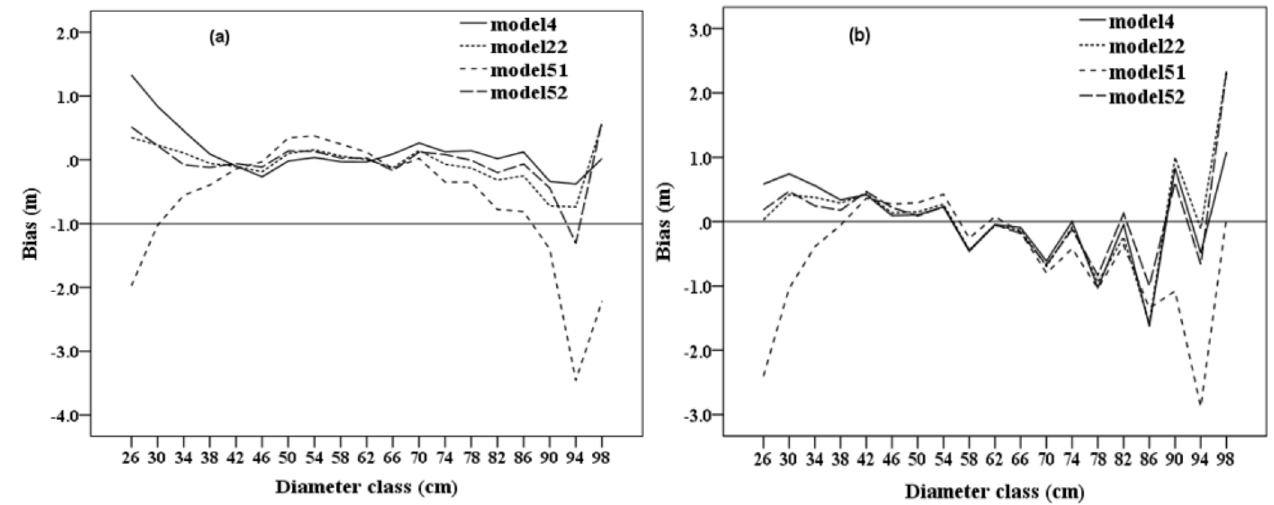
Fig 5. Values of averagedeviationin relationto dbh in the calibration and validationdatasets for the two best models (a: calibrationdata; b: validationdata). doi: 10.6084/m9.figshare.4956284.g005.